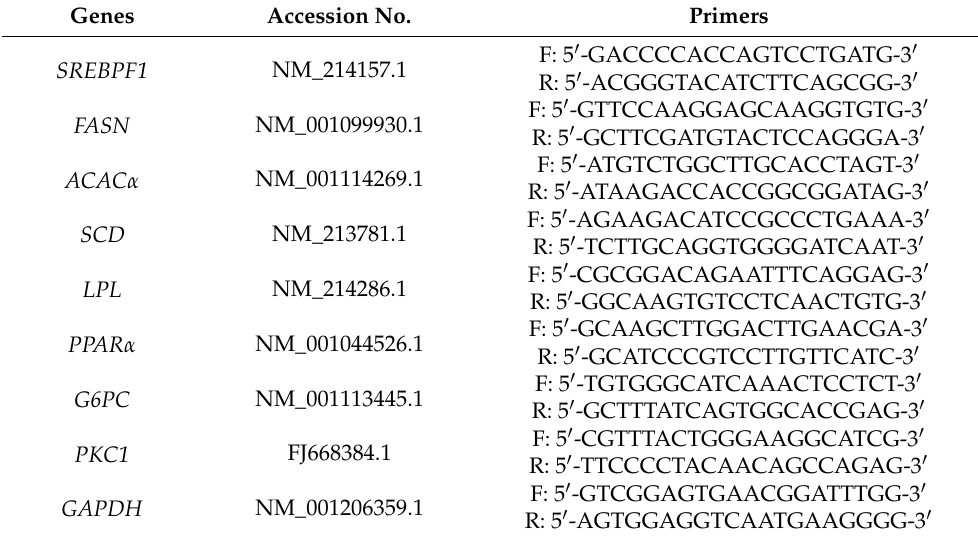
Table 2. Primers used for real-time